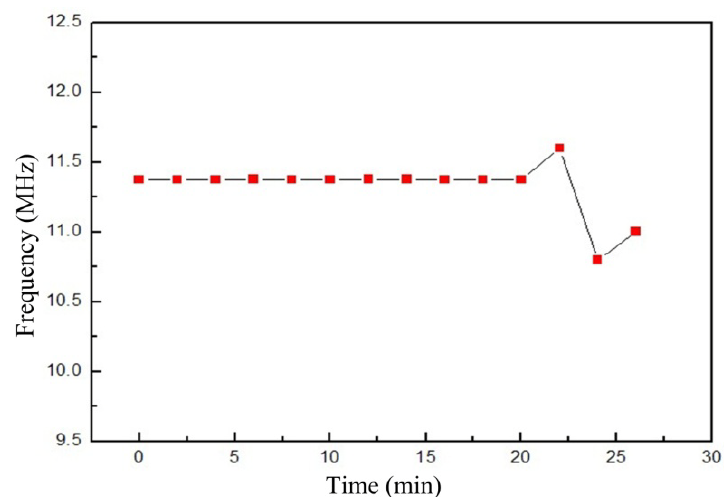
Figure 10. Resonant frequency of the sensor at 850 °C versus